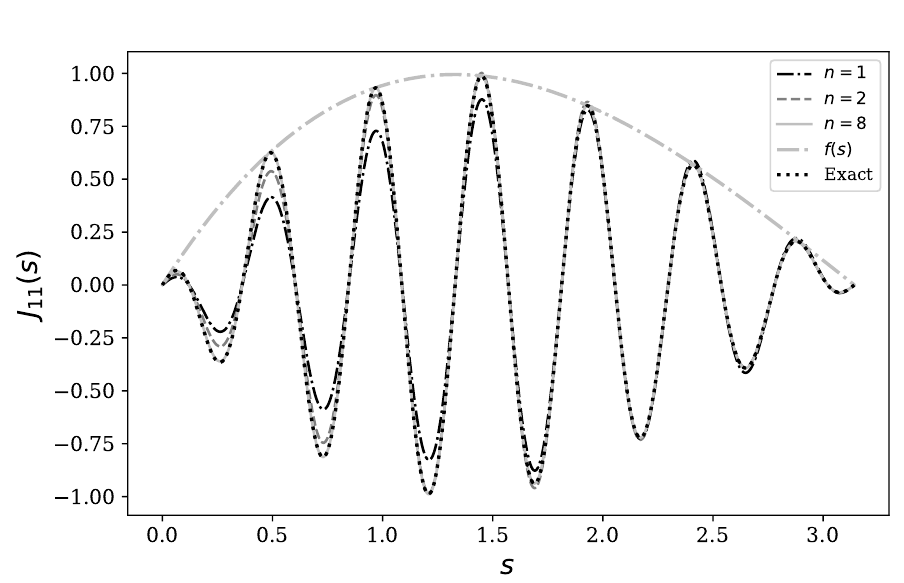
Figure 1. Convergence of the quadrature formula (55) to the exact value of the integral (54) for m = 11 and n =